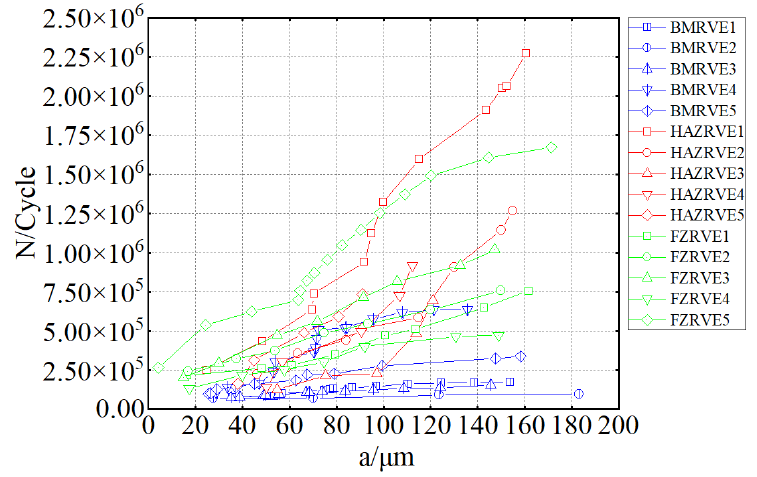
Figure 15. Crack length and life in different areas of the weld toe.